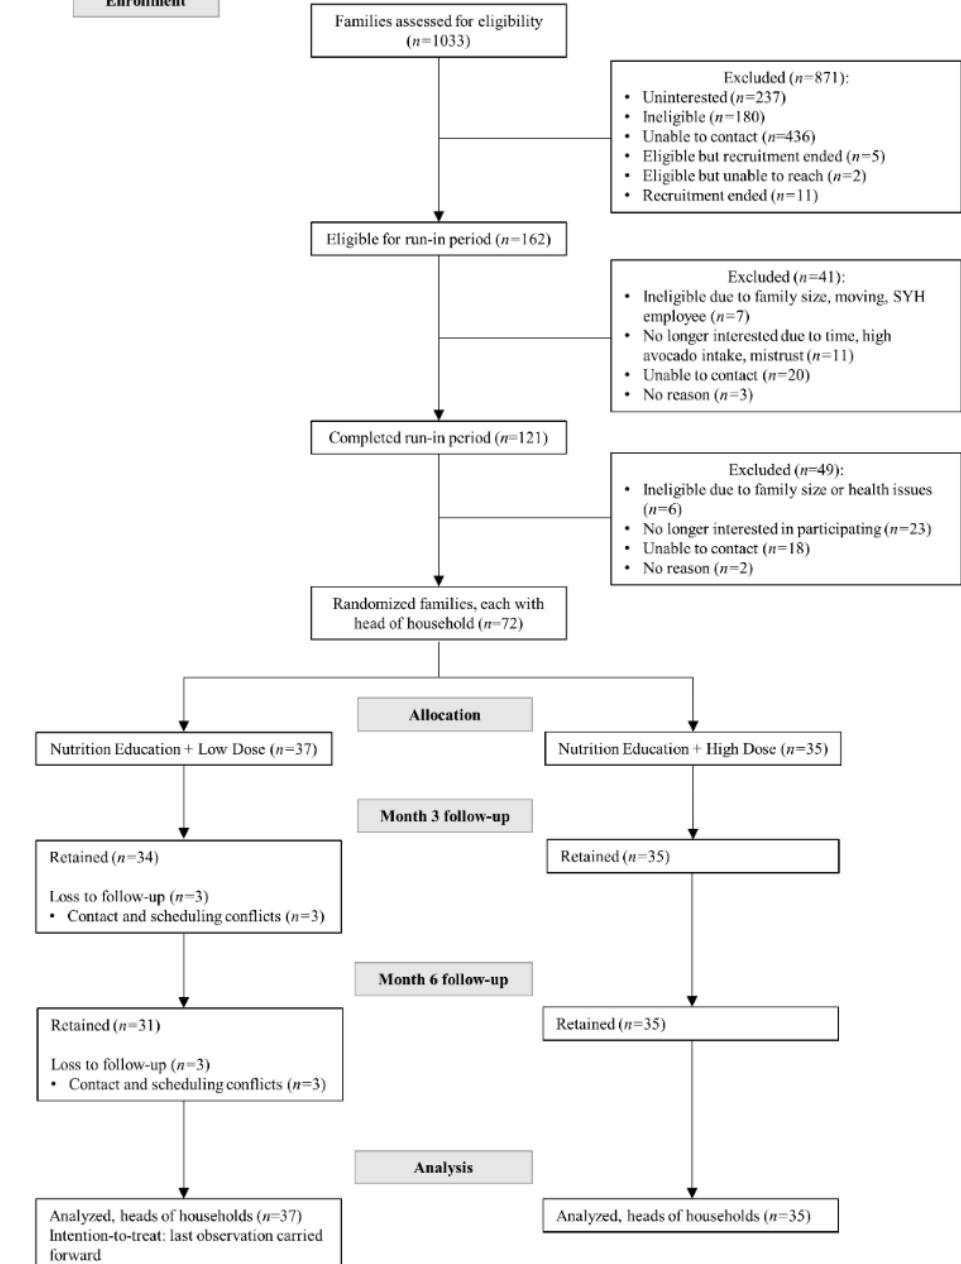
Figure 1. Consolidated standards of reporting trials (CONSORT) flow diagram of the Changes in Biomarkers of Non-Alcoholic Fatty Liver Disease (NAFLD) upon Access to Avocados in His- panic/Latino Adults: Secondary Data Analysis of a Cluster Randomized Controlled Trial, ancillary study of the Effects of Avocado Intake on the Nutritional Status of Families Trial. This figure has been previously published in the parent trial [23]. Table 1. Baseline characteristics of randomized participants 1 .